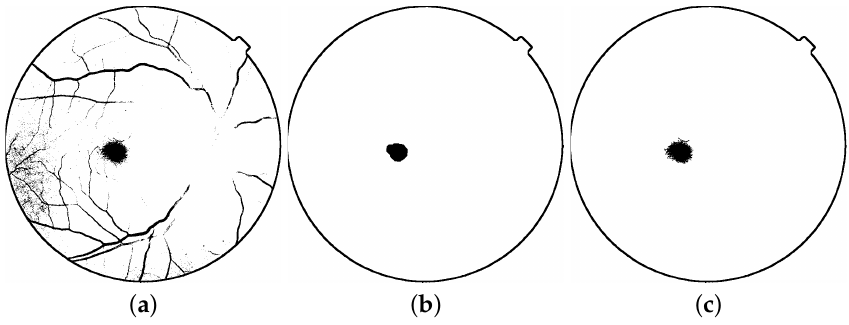
Figure 7. Fovea detection: ( a ) thresholding, ( b ) morphological opening image ( c ) fovea